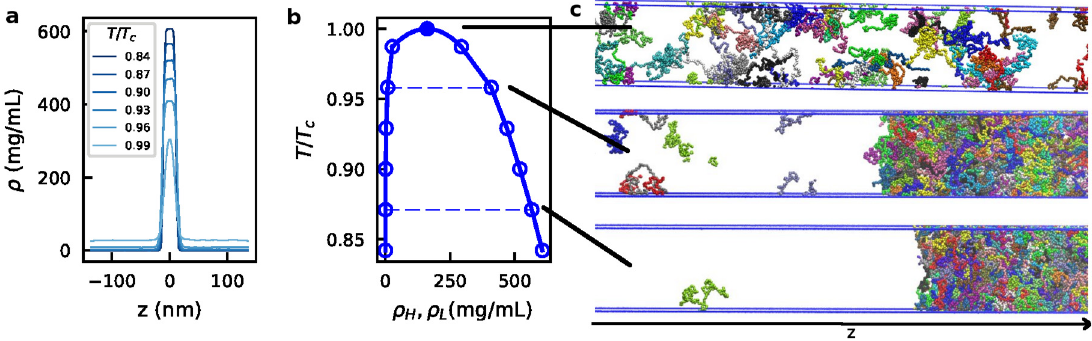
Fig 4. Slab sampling method and typical configurations in different regions of the phase diagram for FUS WT. a) Slab density profile of FUS WT at a set of temperatures where two phases coexist. The raw density plot is highly symmetrical, suggesting good convergence of simulations. b) Phase diagram of FUS WT obtained from the density profile. c) Typical configurations of FUS slab simulations at different